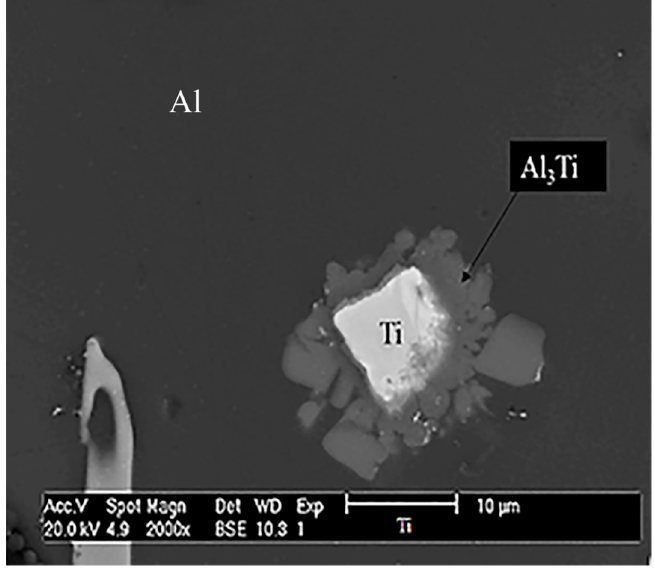
Figure 9. SEM micrograph of a Ti-rich particle, presumably the Al 3 Ti intermetallic Figure 9 . SEM micrograph of a Ti-rich particle, presumably the Al 3 Ti intermetallic compound.